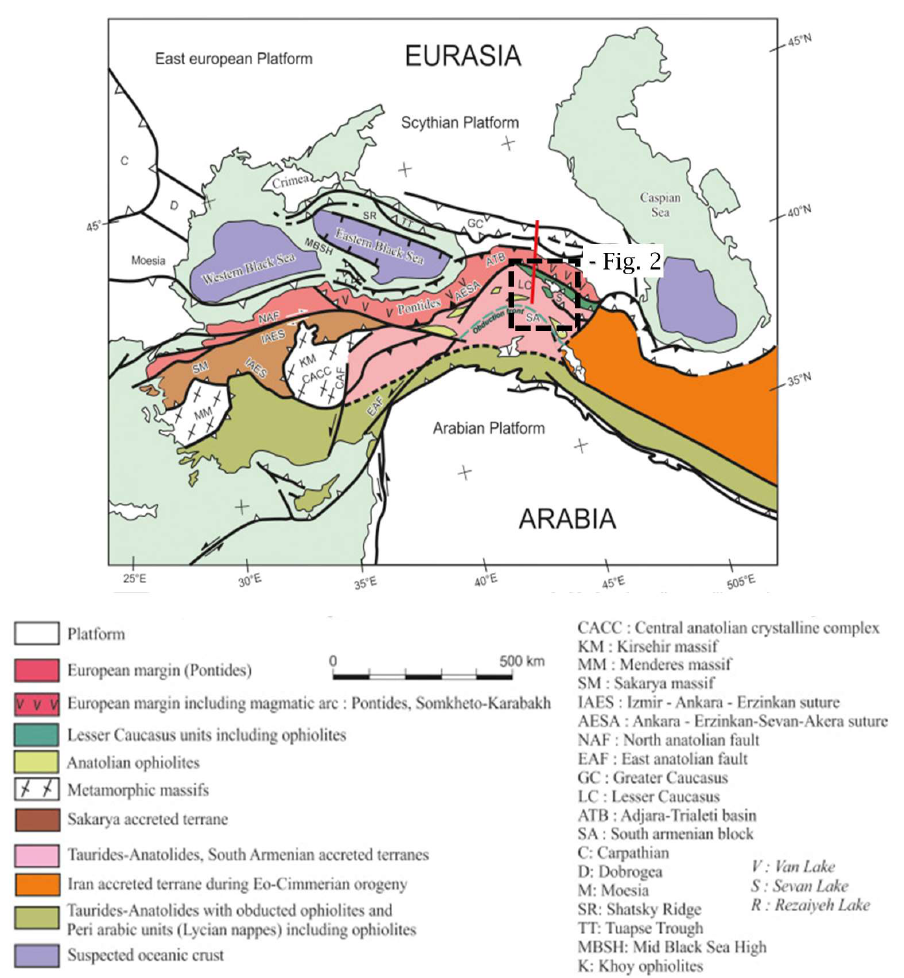
Figure 1. Structural map of the Black Sea Caucasus region. The red line shows the location of the geological section presented in Figure A1. The black dashed rectangle outlines the Armenian geohazard database map shown in Figure 2 (modified after [7,8]).